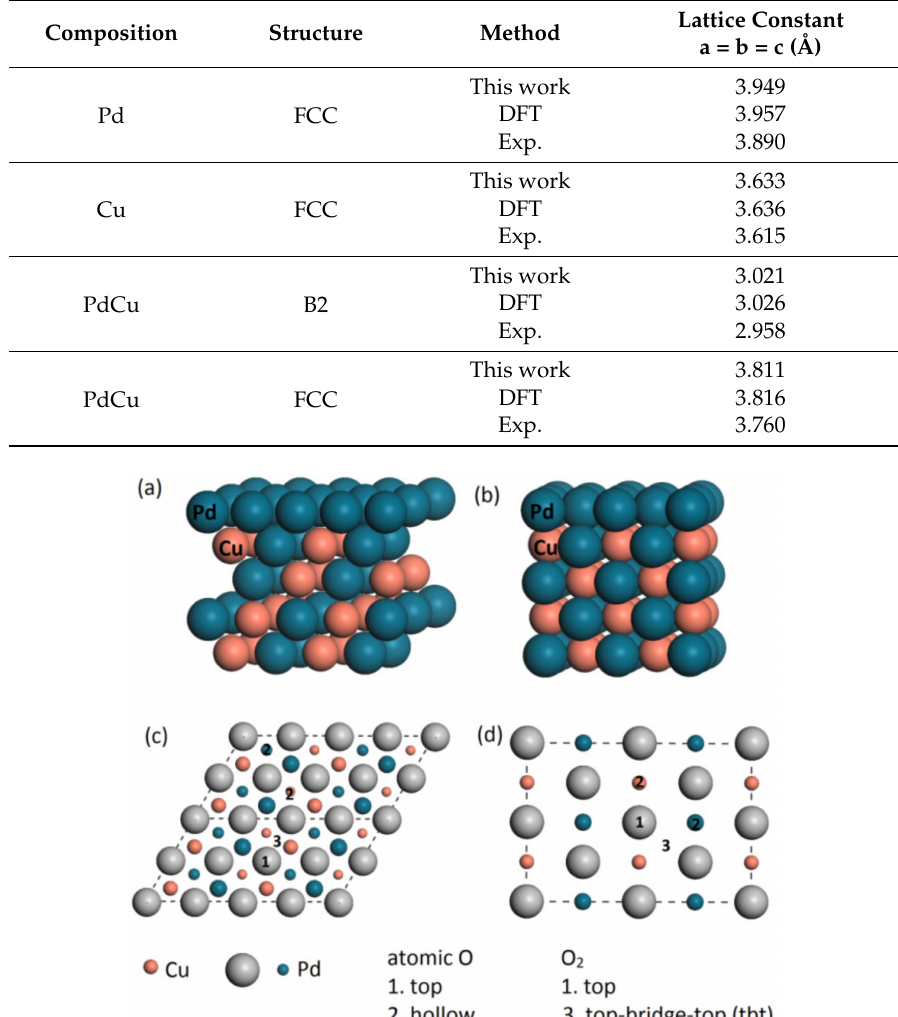
Table 1. The calculated lattice constant for Pd–Cu alloy and intermetallic. The added data are from